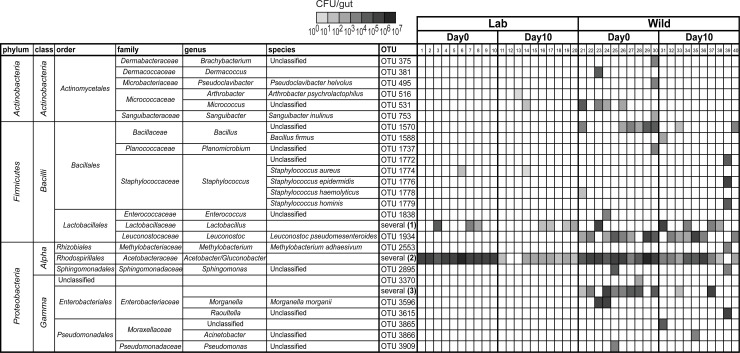
Higher diversity of gut bacterial communities in wild-caught Drosophila melanogaster.Bacterial OTUs present in the gut of laboratory (1–20) and wild-caught (21–40) flies before (Day 0) and after being exposed to the stability protocol (Day 10). Gut homogenates from flies represented in Fig 1B and 1E were plated in different culture media, and representative colonies of each morphological type were sequenced. Each column represents one individual gut. Bacterial levels are represented on a gray scale from 100 to 107 CFUs per gut. Colonies of different Lactobacillus, Acetobacteriaceae, or Enterobactereaceae were not possible to distinguish by morphological type and are grouped together. The presence of Lactobacillus species and Leuconostoc pseudomesenteroides in wild-caught flies is not independent (Pearson’s chi-squared test, p = 0.014). Frequencies of the different OTUs in these groups are represented on Fig 3B, 3D, 3F and 3H and S3B Fig. Supporting data can be found in S6 Data. CFU, colony-forming unit; OTU, operational taxonomic unit.